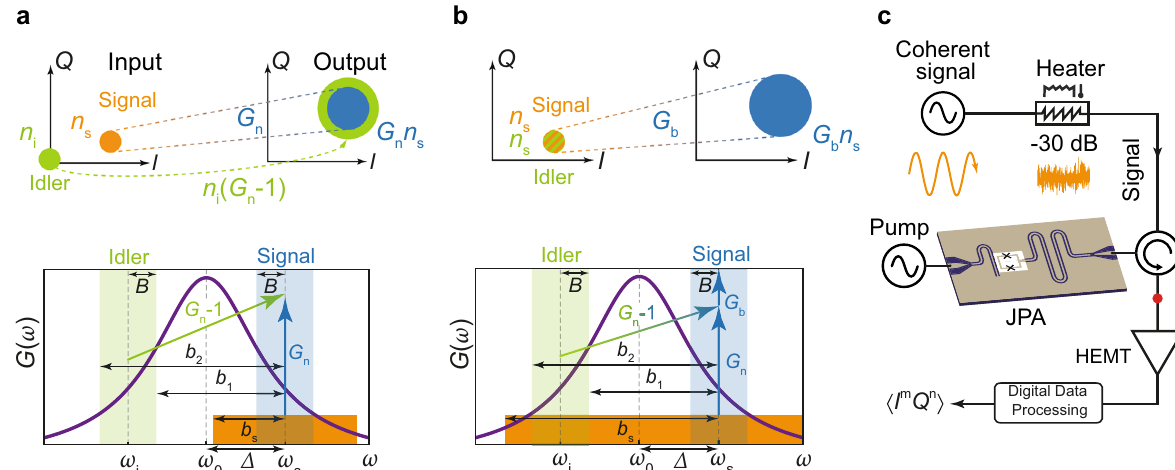
Fig. 1 Phase space representation of nondegenerate parametric ampli fi cation and experimental setup. a Top: Phase space transformation for the ampli fi cation of narrowband input signals. Colored circles depict the respective variances of the input signal (orange), output signal (blue), and idler mode (green). Bottom: Spectrum of parametric ampli fi cation of narrowband signals with bandwidth b s . The purple solid line shows a Lorentzian gain function. Blue-shaded and green-shaded regions represent measurement bands with full bandwidth 2 B around the signal and idler modes, respectively. For input signals with b s ≤ b 1 , the idler adds at least vacuum fl uctuations to the output. b Top: Phase space transformation for ampli fi cation of broadband input signals. The idler does no longer act as a noise port and the signal is ampli fi ed with gain G b = 2 G n − 1. Bottom: Spectrum of parametric ampli fi cation process for broadband signals. If b s ≥ b 2 , each mode in the signal bandwidth corresponds to a correlated input mode on the idler side, resulting in ampli fi cation with the total gain G b and the absence of the SQL. c Illustration of the experimental setup. The ampli fi cation chain consists of a nondegenerate Josephson parametric ampli fi er (JPA) and a cryogenic HEMT ampli fi er. Narrowband coherent states can be applied via a microwave source and a heatable attenuator enables the generation of broadband thermal states. The red dot labels the signal reconstruction